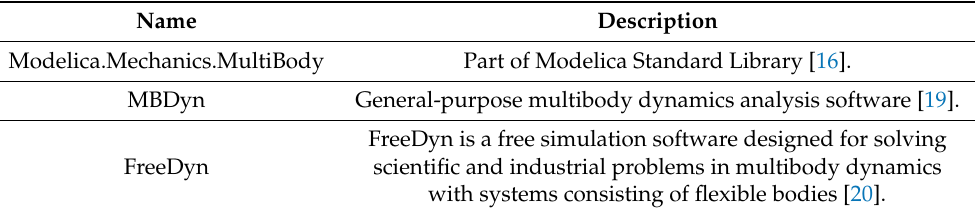
Table 2. Multibody simulation software.